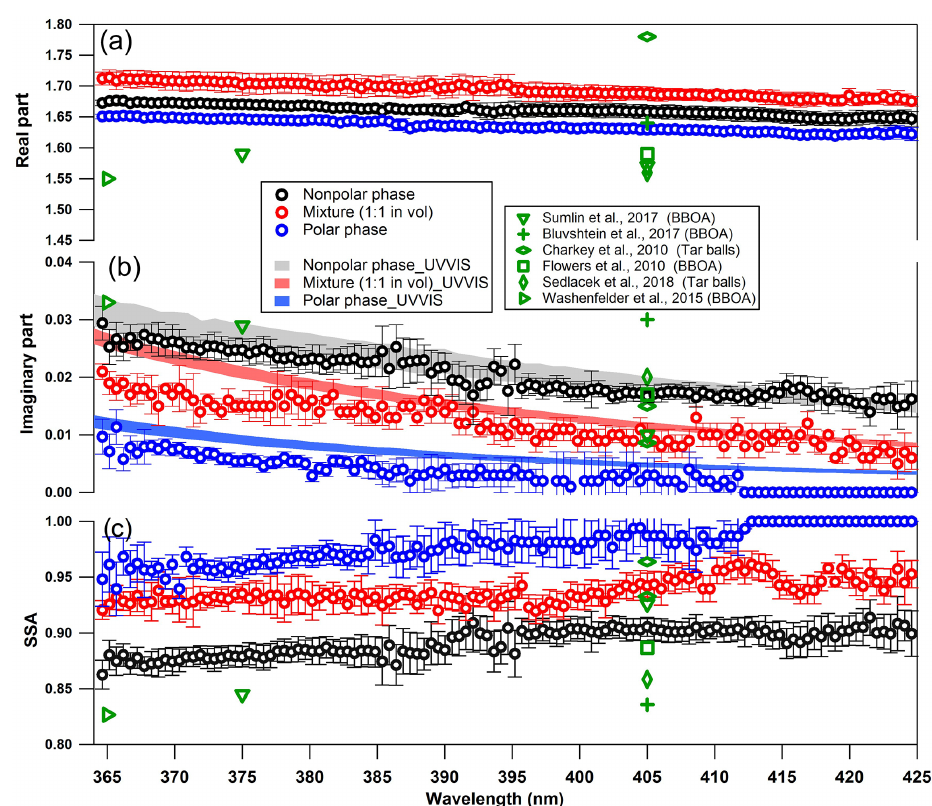
Figure 4. Wavelength-dependent RI and SSA for tar ball particles generated from polar, nonpolar and a mixture of the two-phase tarry solutions (only retrieval for a mixture of 1:1 in vol is shown for clarity; optical results for the other two mixtures can be found in the supporting materials). The shaded areas indicate the upper and lower limits of the imaginary part calculated from UV–visible spectra of methanol extracts from the corresponding tar ball particle samples: (a) real part, (b) imaginary part, and (c) SSA calculated for 150nm particles. Overlaid in green symbols are previous measurements of biomass burning from the